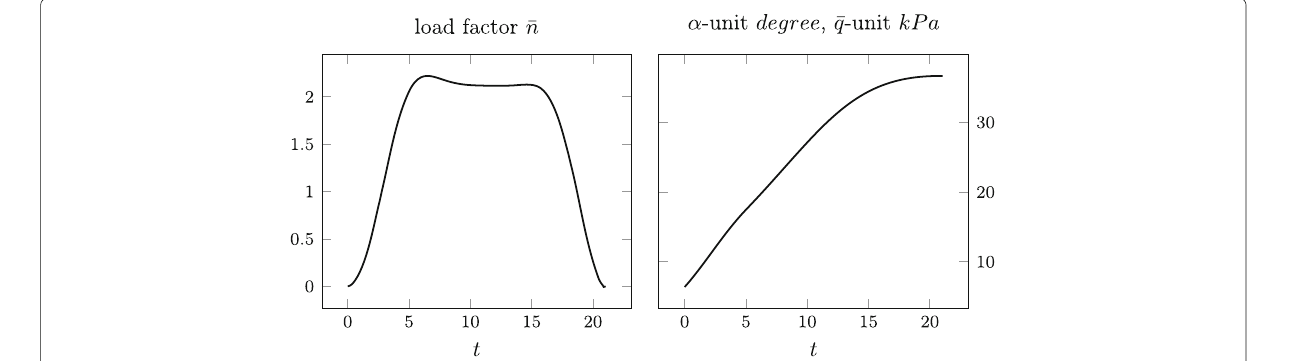
Fig. 20 Time history of the constraints c ( x ( t )) during the pull-up maneuver